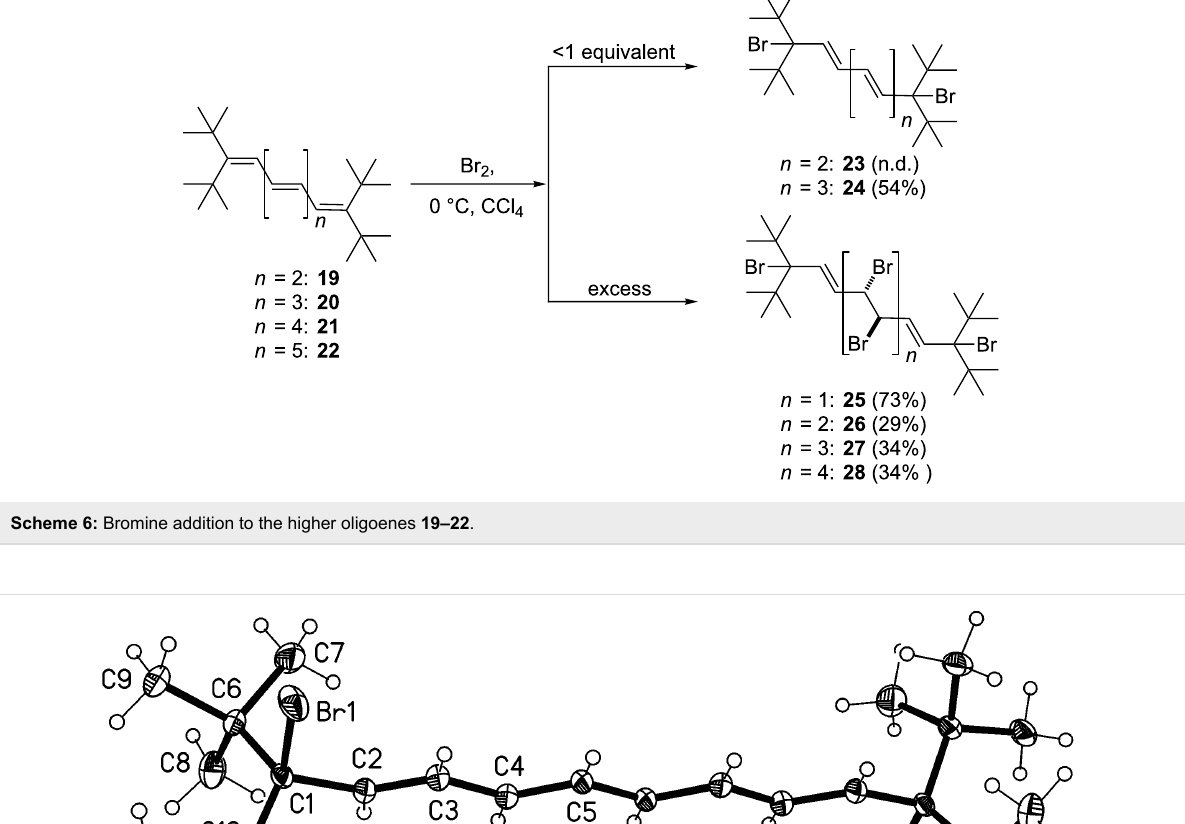
Scheme 6: Bromine addition to the higher oligoenes 19–22 .